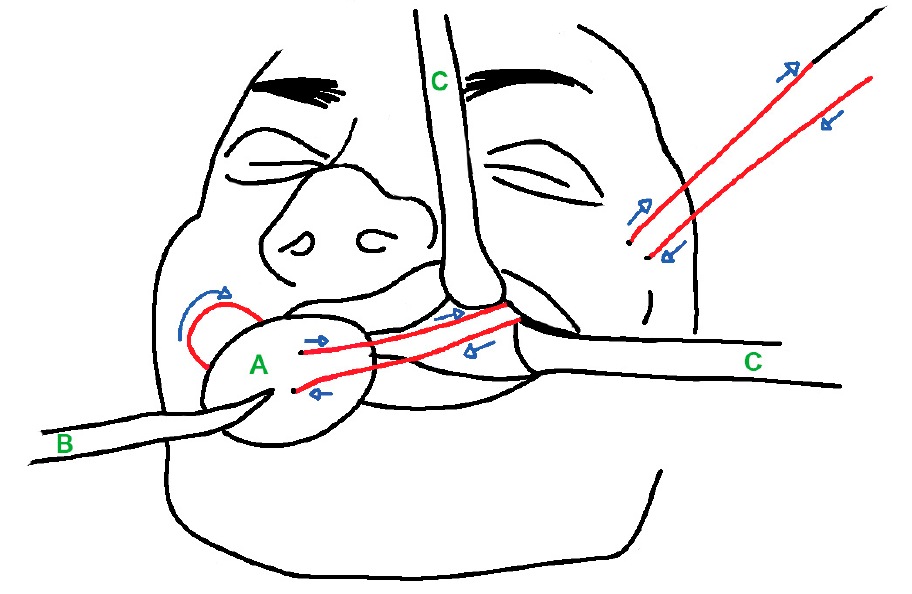
Figure 4. Schematic figure of the technique using a malar implant. The implant (A) is held externally with Klemmer forceps (B). While the periosteal pocket is kept open by two retractors (C), the suture (red line) is passed through the planned points, from the skin to the pocket through the implant and reverse, as shown by the blue arrows.